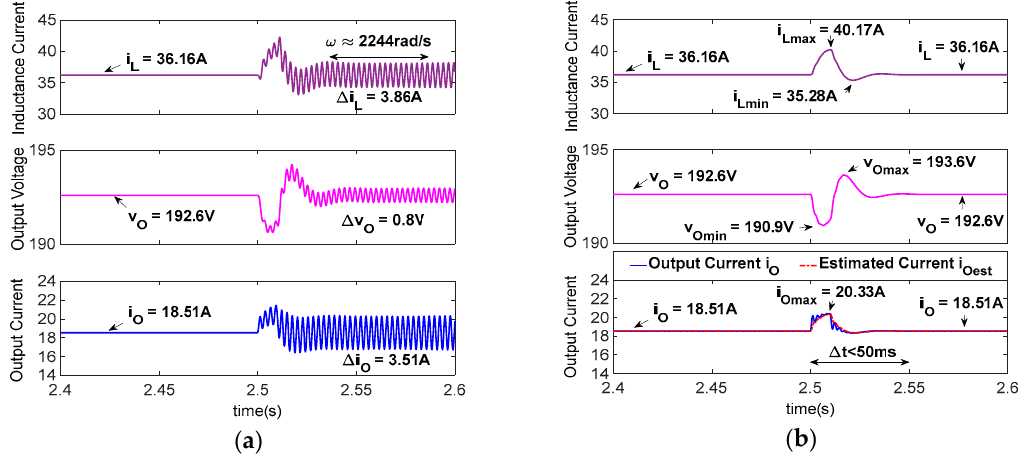
Figure 18. Comparative simulation results of the studied dc microgrid system with the CPL-side capacitance perturbations. ( a ) Conventional droop controlled system; ( b ) Proposed NDOB-VNI stabilizing strategy controlled system.